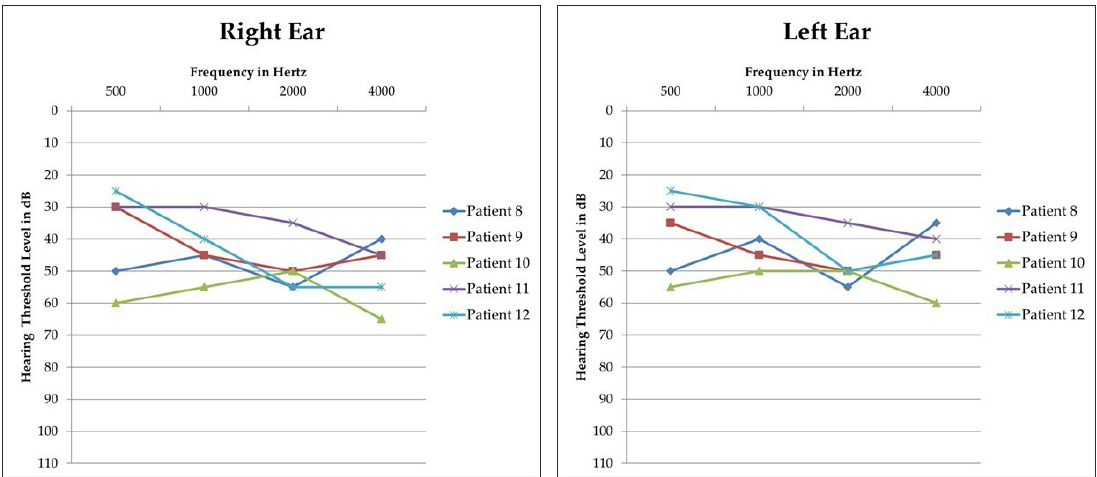
Figure 2. Audiograms of patients carrying a heterozygous STRC deletion and a hemizygous pathogenic or likely pathogenic in trans variant. Threshold of the right and left ear of each patient is reported separately. All patients display mild-to-moderate bilateral sensorineural HL with a symmetric pattern between the right and left ear. Patient 13 did not undergo PTA but only ABR, due to her age. Table 2. STRC deletions and SNVs identified in the six patients that underwent both MLPA and LR-PCR analyses. Gene: gene carrying the deletion or the identified variants with NCBI RefSeq accession number of the considered protein-coding transcripts (NM_). cDNA change and Protein